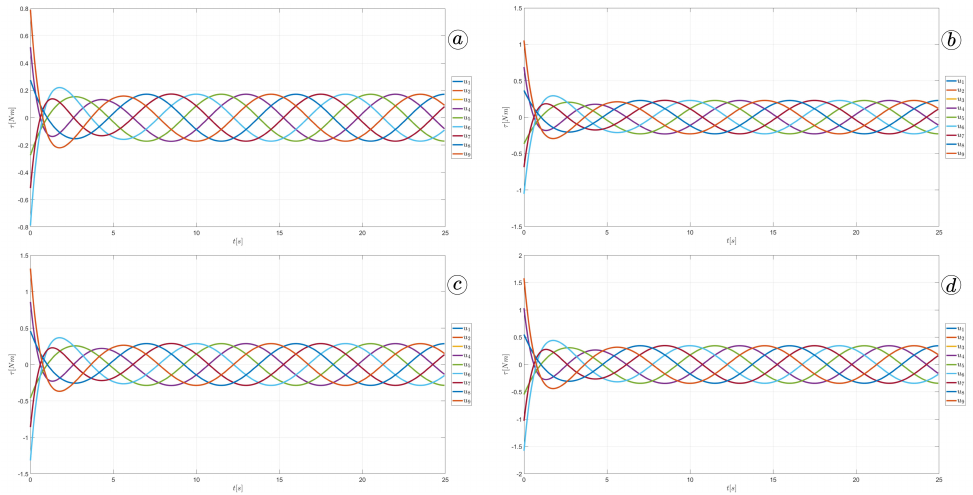
Figure 27. Torque in robot’s joints for α = 30 ◦ ( a ), α = 40 ◦ ( b ), α = 50 ◦ ( c ), and α = 60 ◦ ( d ). The simulation results have been gathered in Table 1. Column d indicates the distance travelled by the robot’s head after 25 seconds of simulation; max ( | u | ) is the maximum value of torque applied to the robot’s joints; V is the final velocity of the robot head in the 25th second of the simulation; max ( | θ | ) , max ( | φ | ) are the maximum value of the link and